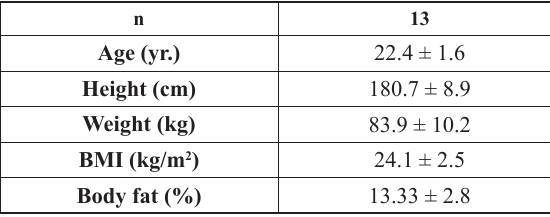
Table 1. Physical characteristics of the